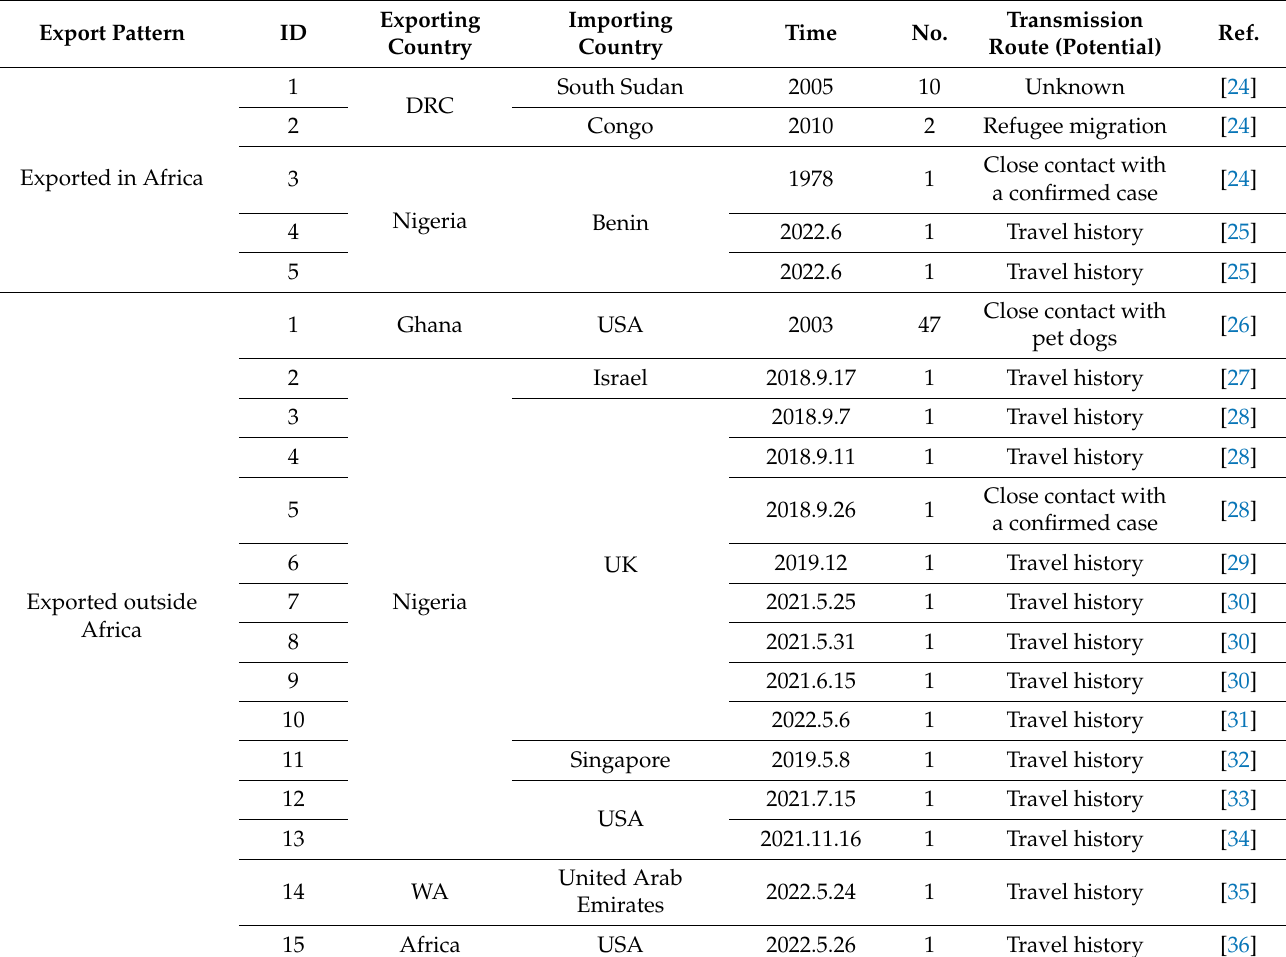
Table 1. Exported mpox from West and Central